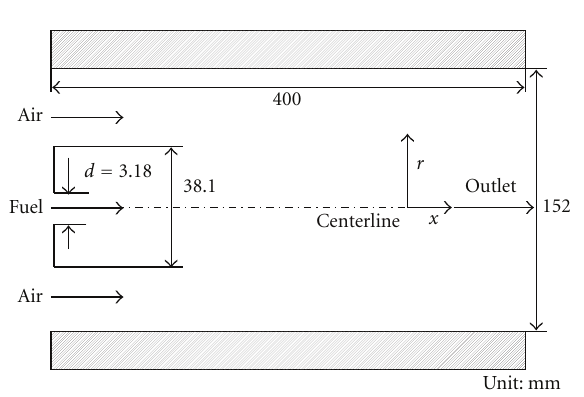
Figure 3: Plot of the weight function.